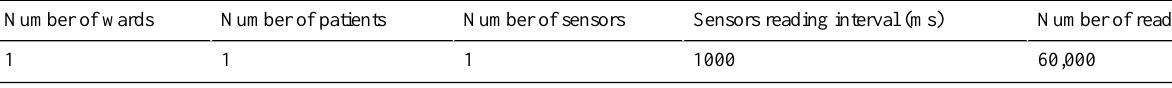
Table 1. Defining the configuration for our 5 experiments.